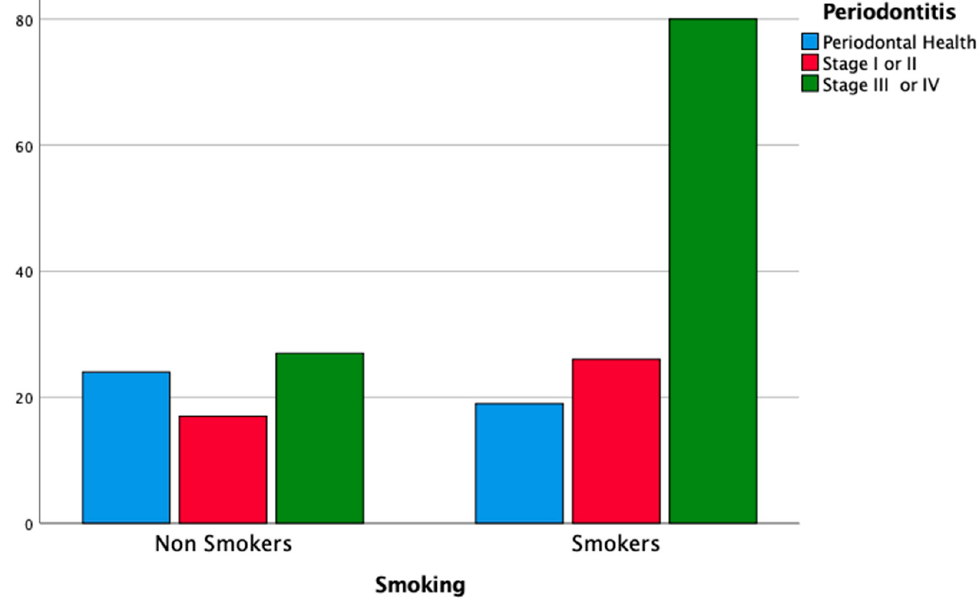
Figure 1. Distribution of periodontitis according to the habit of smoking.